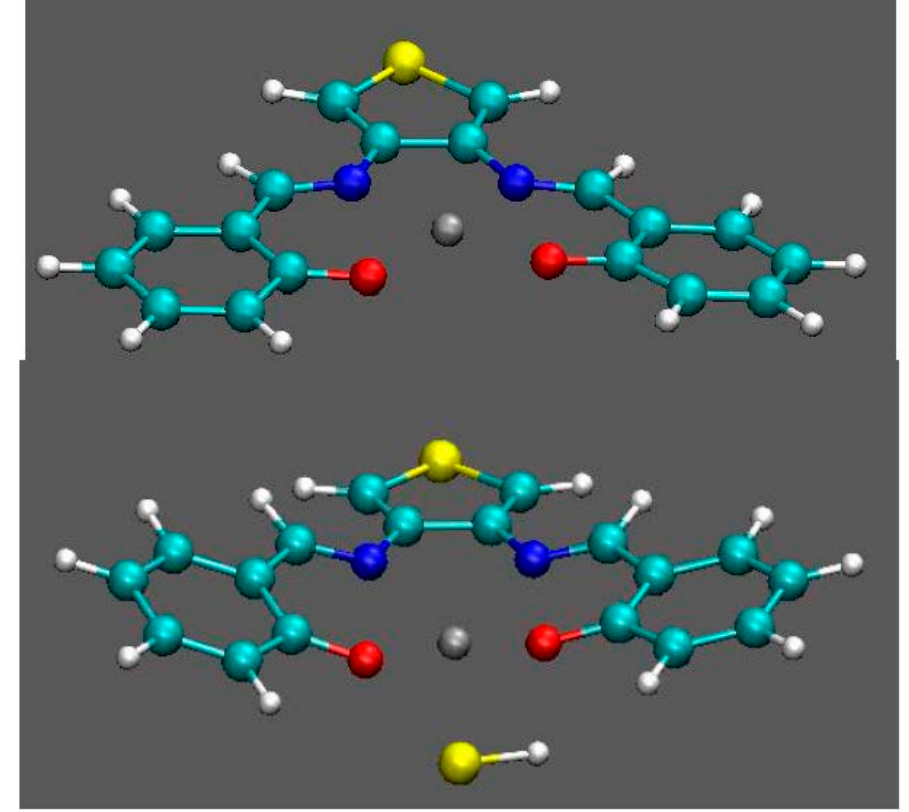
Figure 3. Optimized geometry for complex 1 ( top ) and its adduct with HS − ( bottom ).